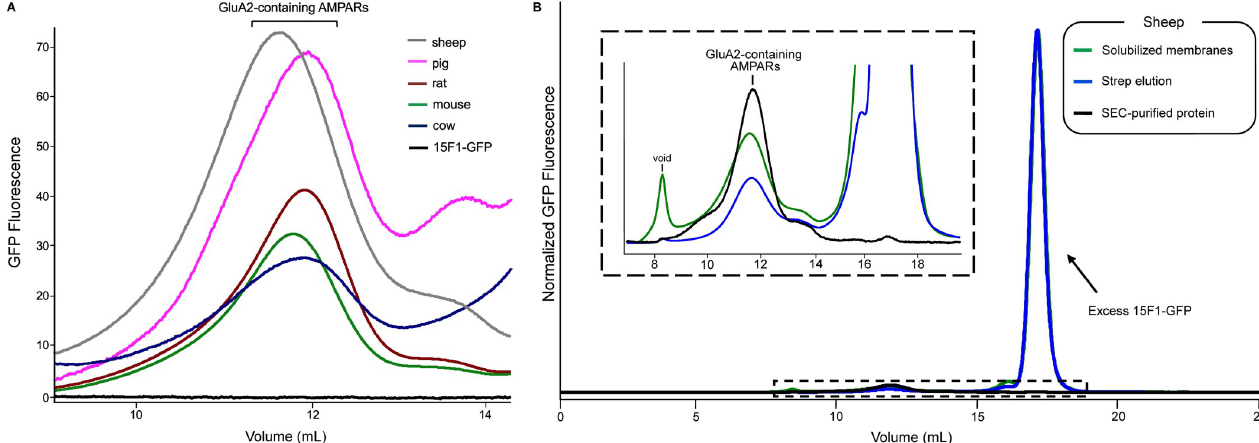
Fig 3. Solubilization and immunoaffinity purification. ( A ) Cross-species comparison of GluA2 elution position and abundance. The 15F1-GFP Fab was added to digitonin-solubilized membranes and the resulting samples were analyzed by FSEC. All traces were from equal masses of membranes. ( B ) FSEC traces of native sheep AMPARs analyzed throughout the immunoaffinity purification process using GFP fluorescence. Inset: Magnified view highlighting the peaks corresponding to native sheep AMPARs outlined by the dashed rectangular box.